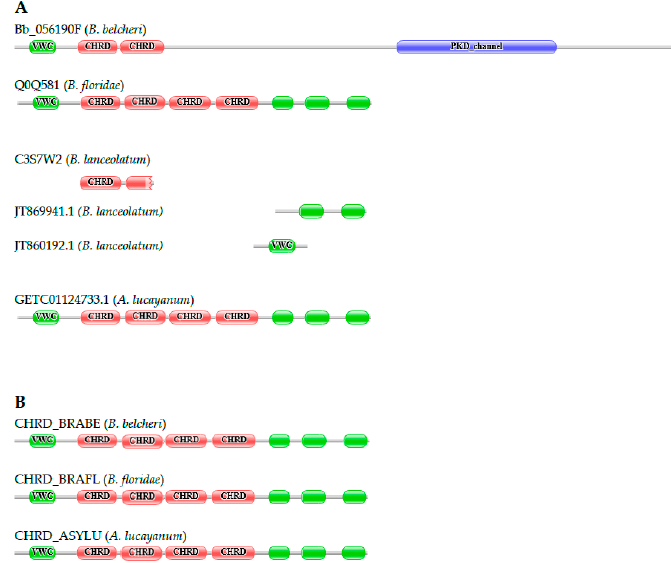
Figure 5. Chordin ( CHRD ) genes encoding proteins with domain architectures typical of vertebrate chordins are present in the genomes of B. belcheri , B. floridae , and A. lucayanum . ( A ) The